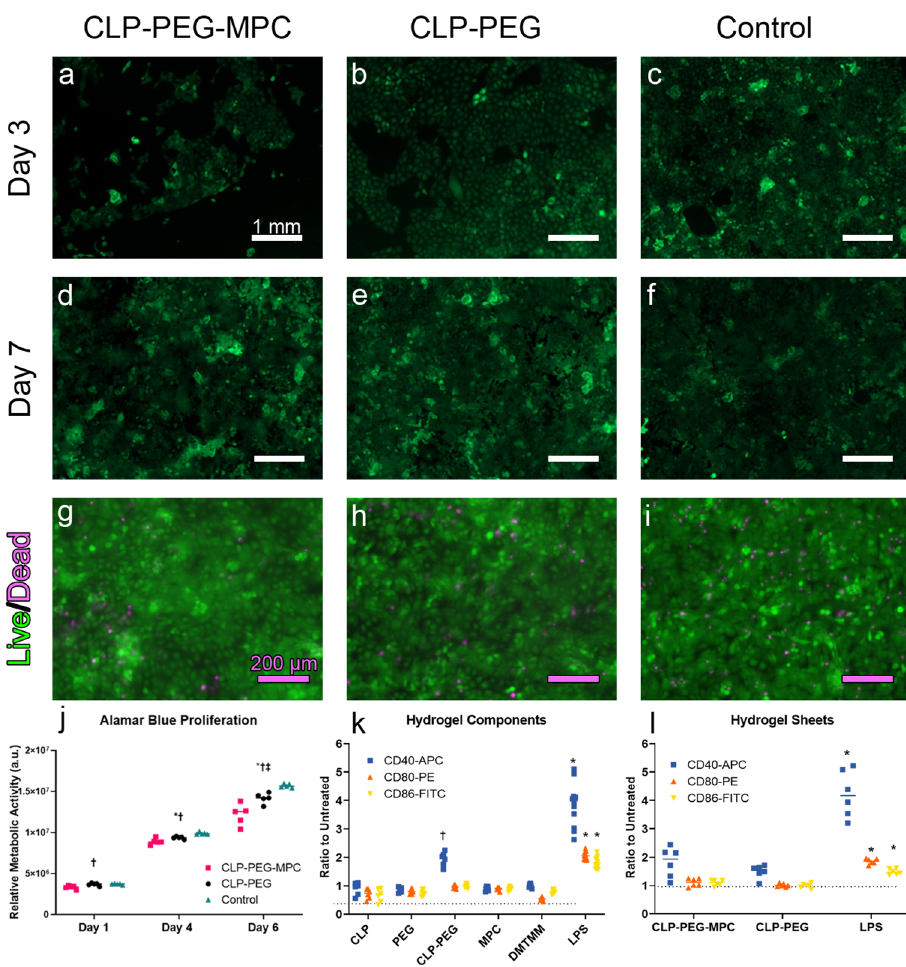
Fig. 2 In vitro analyses of CLP-PEG-MPC and CLP-PEG hydrogels. a – f GFP-tagged human corneal epithelial cells proliferated on both CLP-PEG-MPC and CLP-PEG hydrogels over 7 days ( n = 4 per group). White scale bars, 1 mm. g – i Live/dead pictures of human corneal epithelial cells proliferated on both CLP- PEG-MPC and CLP-PEG hydrogels over 6 days (green represents live cells and magenta represents dead cells) ( n = 5 per group). Red scale bars, 200 µ